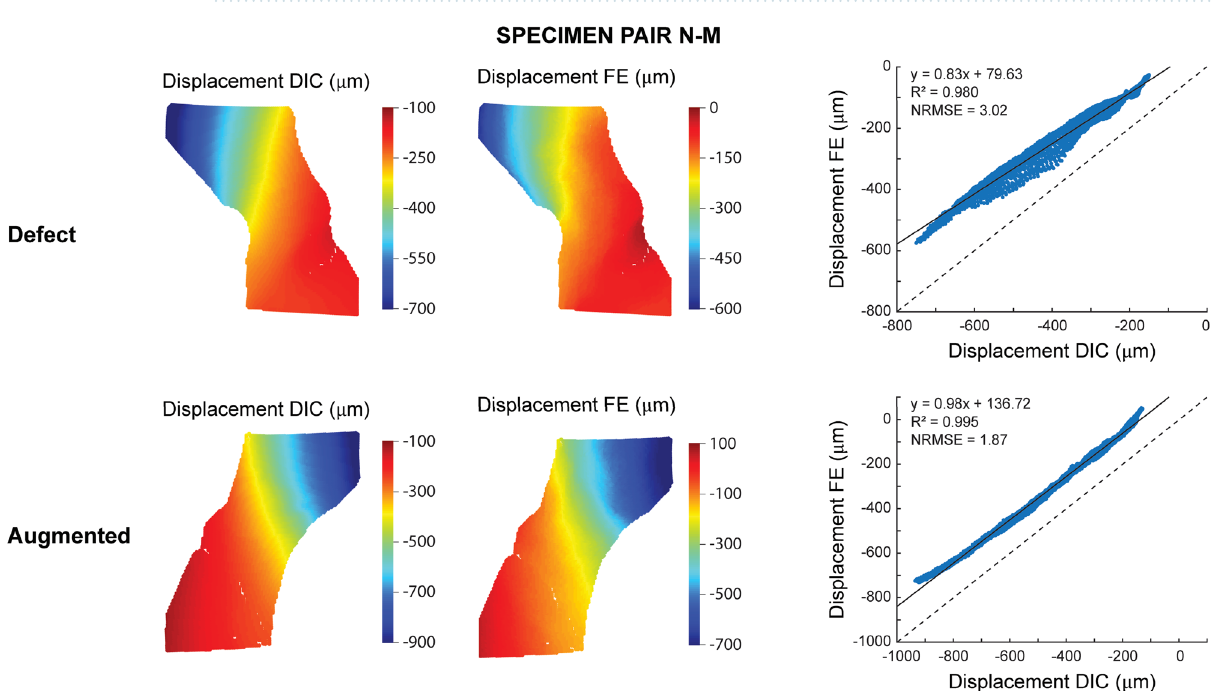
Figure 4. Validation displacements. (Left) Qualitative comparison of the DIC and FE displacements at the anterior surface of the proximal femur. The results are displayed for one representative specimen pair (N–M) at 75% peak experimental force. Note that the scales for the FE and DIC measurements were not matched to allow a better visual comparison of the relative distribution. (Right) Quantitative comparison of the displacement values through linear regression